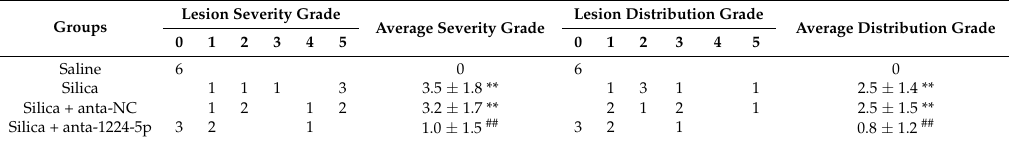
Table 1. Effect of miR-1224-5p antagomir administration on lung